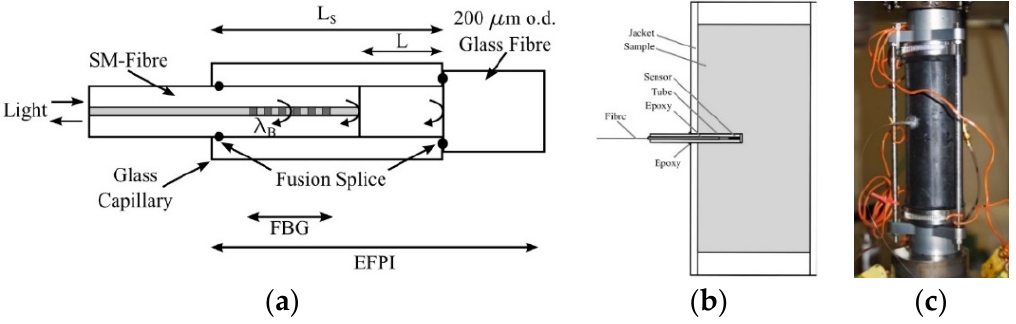
Figure 10. Schematic of an EFPI FOS that was designed for the measurement of pressure [71]: a FBG FOS was integrated inside the EFPI in order to compensate for temperature cross-sensitivity ( a ). The developed FOS was applied to measure pressure and temperature inside rock samples ( b , c ) and thus to characterize their. Reprinted with permission from Ref. [71]. Copyright 2012 International Journal of Rock Mechanics and Mining